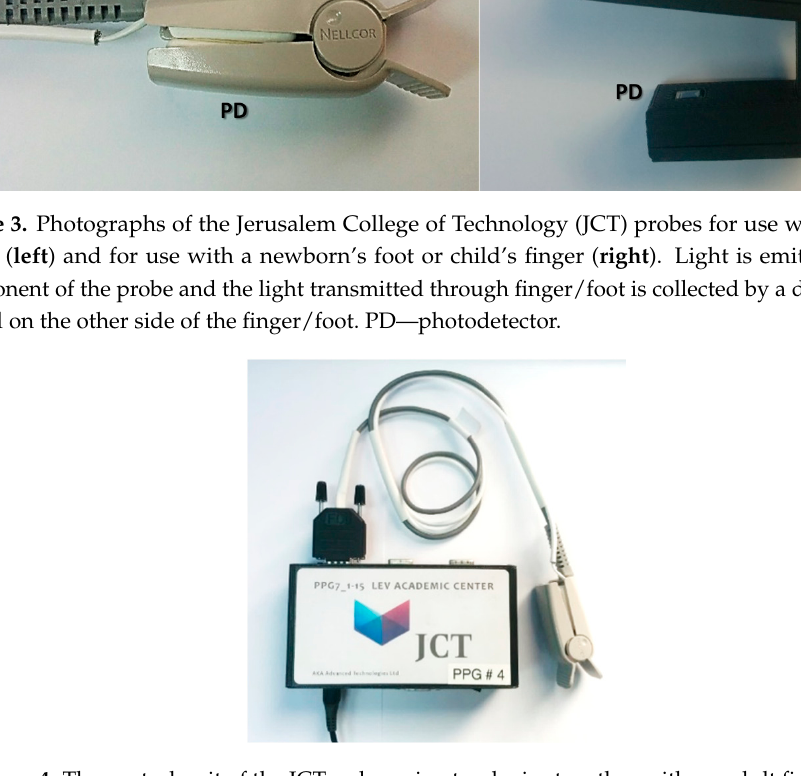
Figure 4. The control unit of the JCT pulse oximeter device together with an adult finger probe.